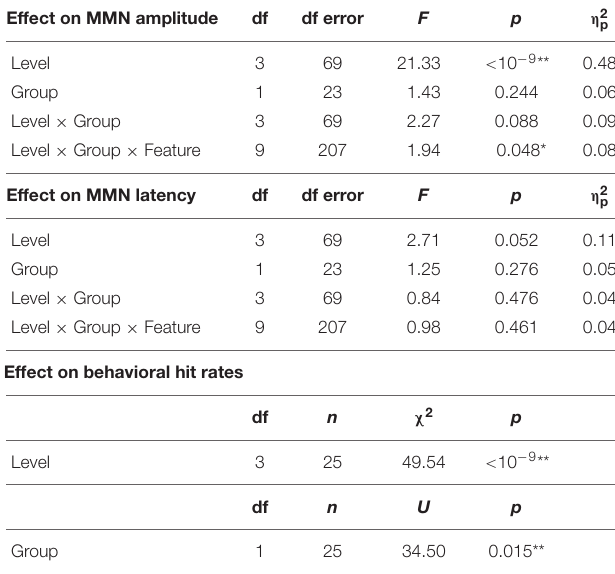
TABLE 3 | Analysis of